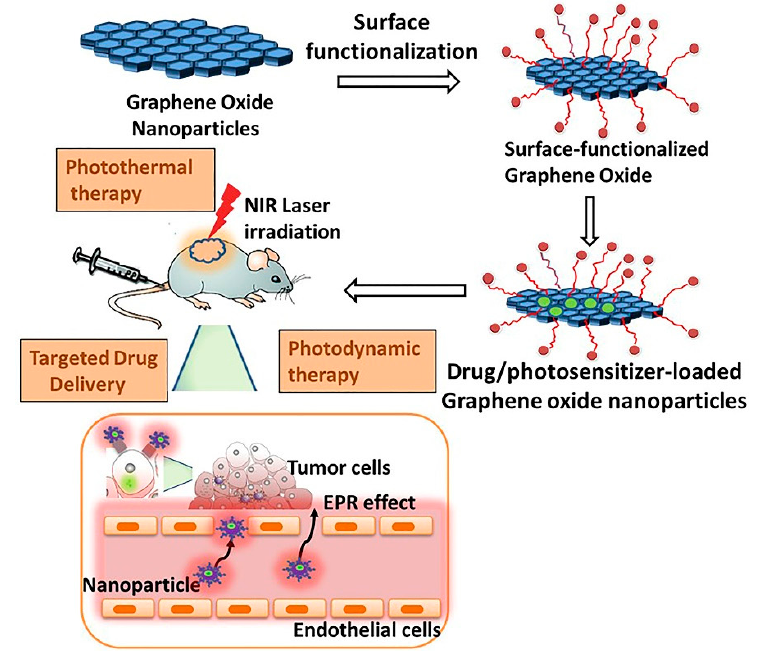
Figure 2. Surface functionalization of graphene oxide (GO) nanoparticles (NPs) and loading of drug and photosensitizer on the surface-modified GO–metal NPs. Finally, the application of GO nanocomposites for targeted drug delivery and in vivo photodynamic therapy using the near-infrared (NIR) laser irradiation is shown.